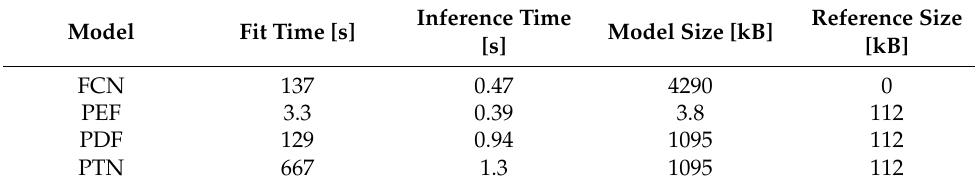
Table 3. Computational and storage